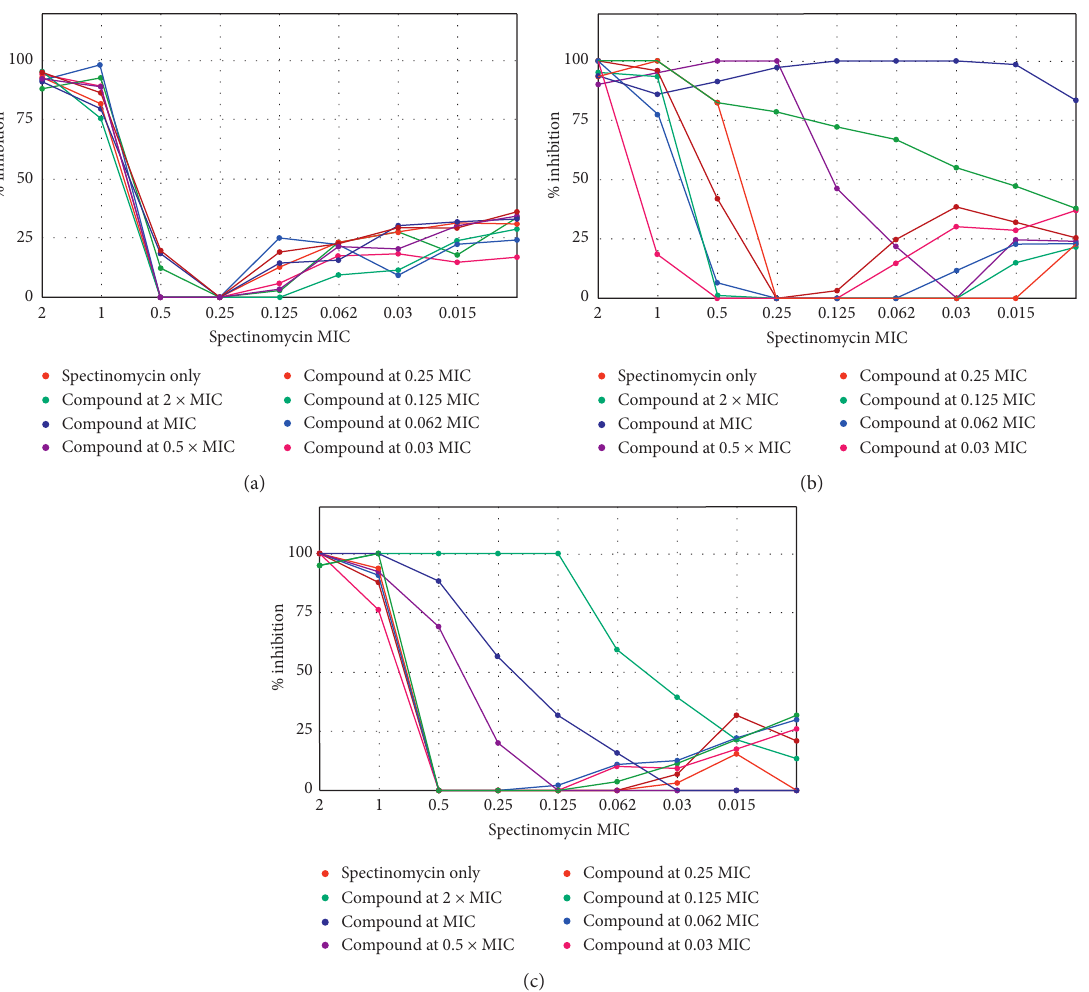
Figure 3: Percentage inhibition of compound 1 (a), 5 (b), and 6 (c) at various concentration combination points where the concentration of spectinomycin (as a function of MIC) is indicated on the x -axis combined with multiples of the MIC of the test compound as indicated by the colors in the